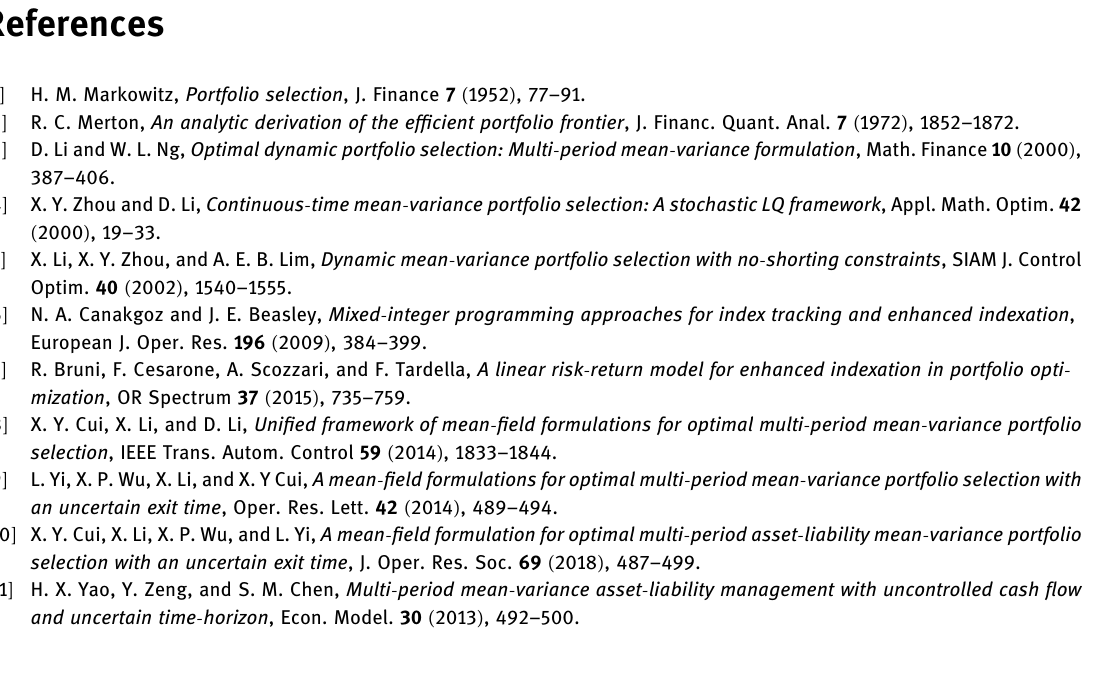
Figure 2 is the e ffi cient frontier of M – V model with liability and random cash fl ow under uncertain exit time. It can be seen that as the expectation go up, the more stable the investment, the less risk it takes, which has the same conclusion as Figure 1. Actually, Example 2 is a special case of Example 3, where we degenerate the term of liabilities to